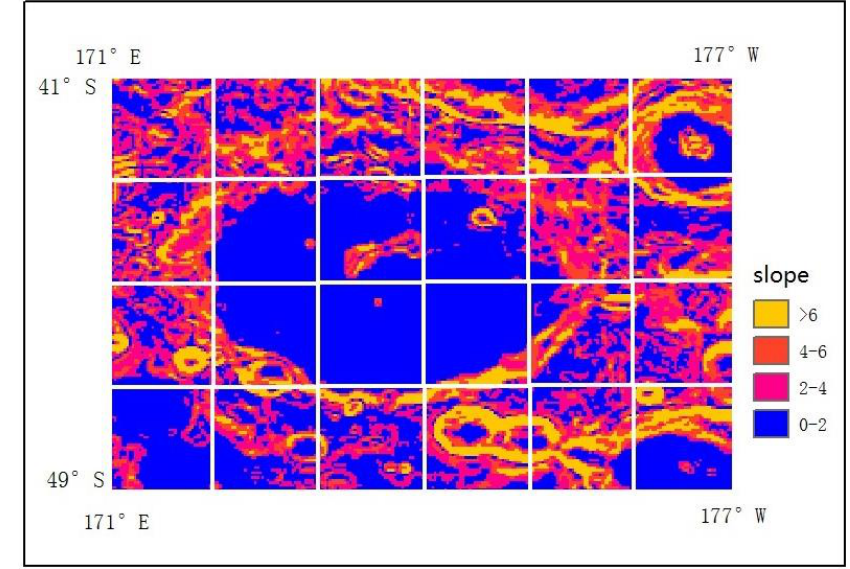
Figure 5. Slope grade map of Von Karman